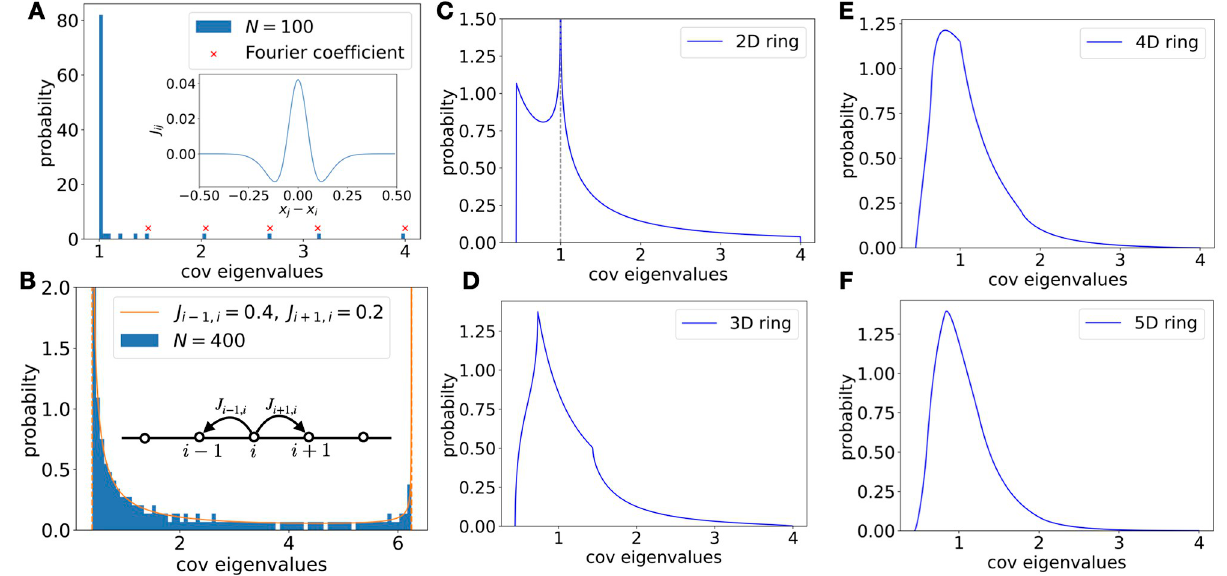
Fig 10. Covariance spectra under some deterministic connectivity models. A . Histogram of the covariance eigenvalues of a ring network with a long- range connection profile (inset, N = 100). Most eigenvalues are close to 1 and the rest of eigenvalues converge to discrete locations predicted by top Fourier coefficients (crosses) of the connection profile (Eq (36)). B . Same as A. but for a ring network with Nearest-Neighbor connections: J i − 1 = 0.4, J i +1, i = 0.2. The solid line is theoretical spectrum in large N limit which has two diverging singularities at both support edges. The effect of such singularities is also evident in the finite-size network at N = 400 (a single realization). C-F . Higher dimensional Nearest-Neighbor ring network ( ad = 0.6, see Methods). As the dimension increases, the singularities in the pdf become milder and less evident, and the overall shape becomes qualitatively similar to the random connectivity case (Fig 1).